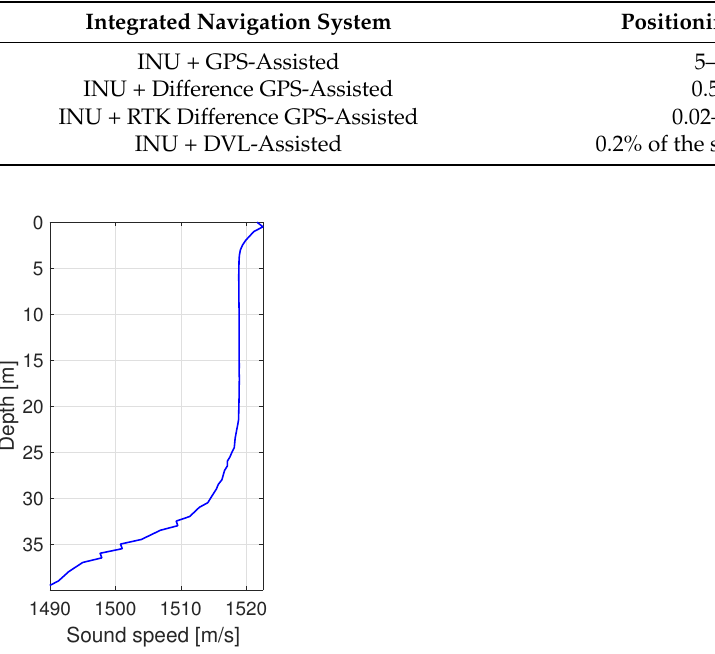
Table 1. Positioning accuracy of the integrated navigation system.